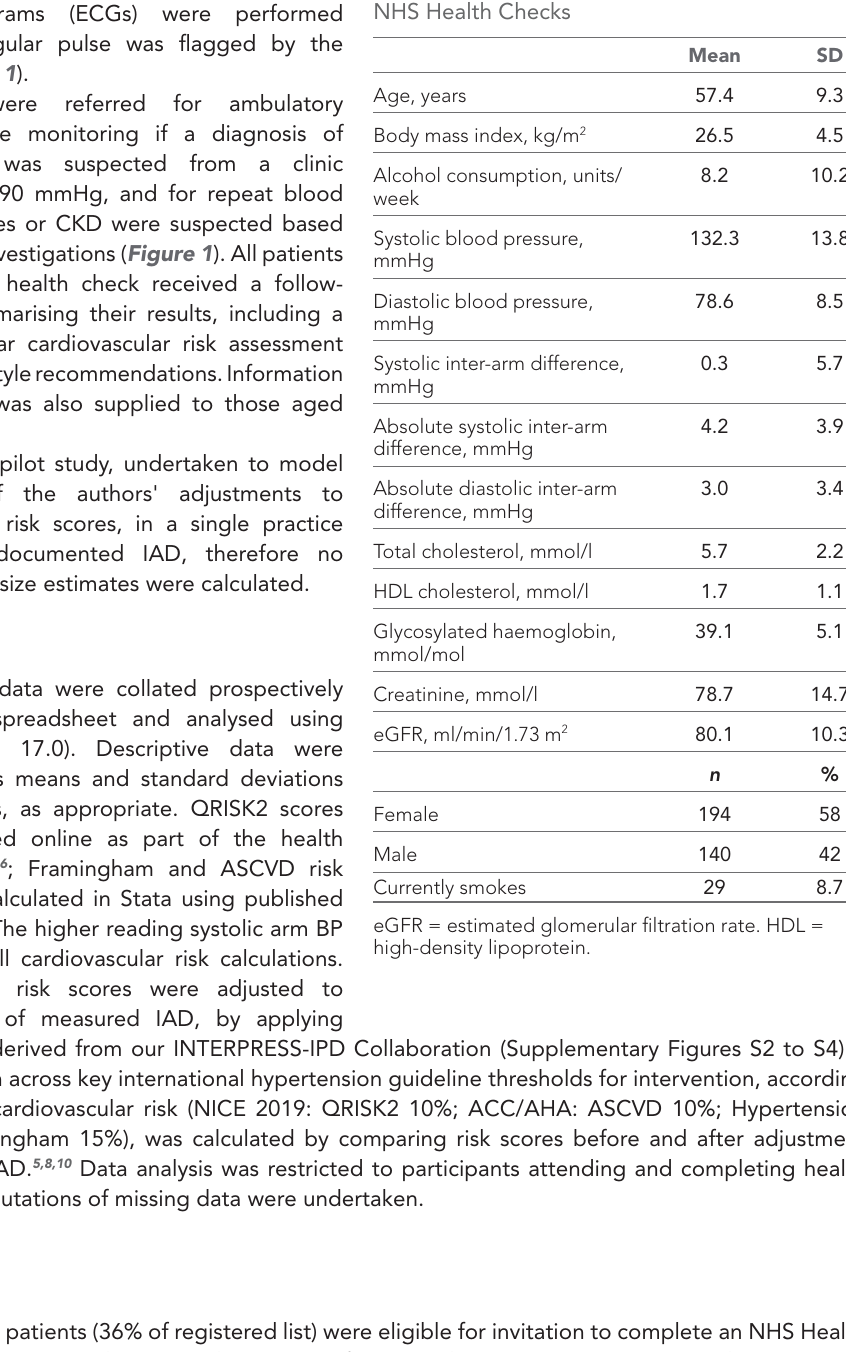
Table 1 Characteristics of 334 participants